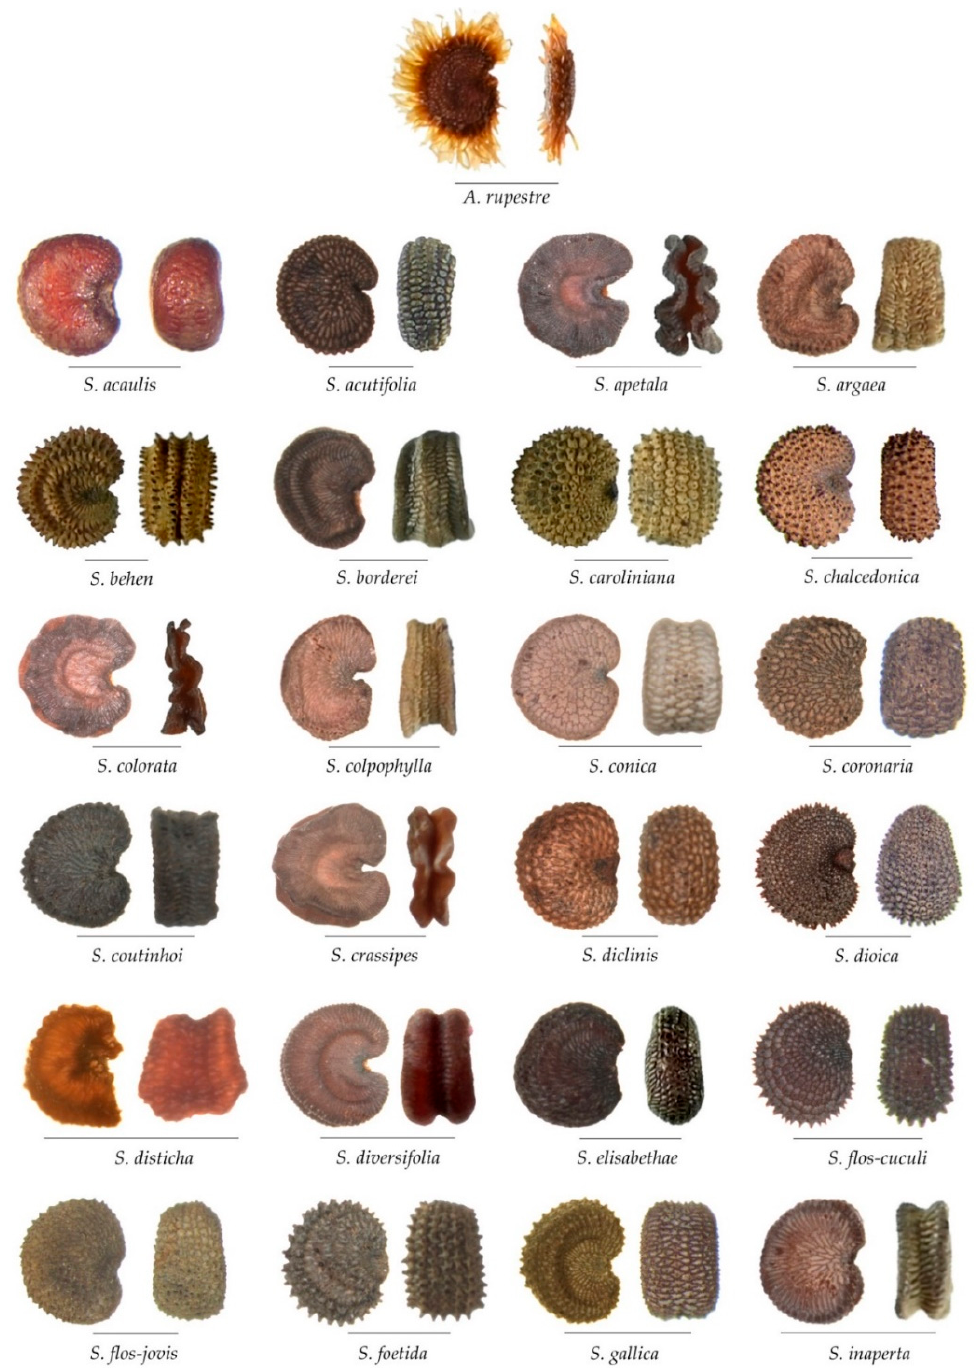
Figure A1. A seed of Silene apetala ( left ) with the corresponding convex hull ( center ). The image on the right shows the area of the convex hull corresponding to the seed image. Solidity is the ratio between the area of an object and the area of a convex hull of the same object. In the seed image of the figure, solidity equals 0.94. Solidity equals one in convex figures.